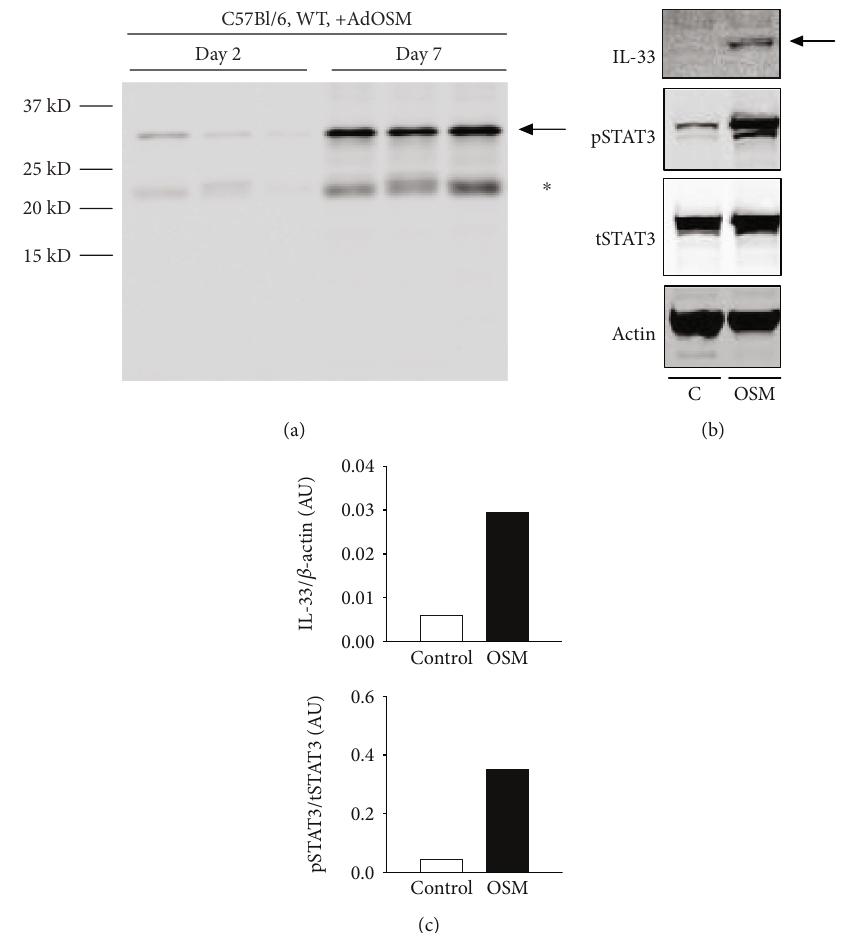
Figure 9: Comparison of AdOSM-induced IL-33 expression in C57Bl/6 mouse lung using the Nessy-1 monoclonal antibody and OSM- induced IL-33 upregulation in Human Type 2 Alveolar Epithelial Cells (A549). (a) C57Bl/6 wild-type (WT) or IL-33 knockout (IL-33KO) mice were endotracheally administered AdDl70 (control) or AdOSM for 7 days, and whole lung cell lysate was analyzed for the expression of IL-33 by Western blotting using the Nessy-1 monoclonal antibody. (b) 300,000 A549 cells/well in 6-well plates were stimulated with human OSM (20 ng/ml) for 24 hours, and Western blot analysis was performed for detection of IL-33 (Nessy-1), pSTAT3 (NEB Cell Signaling), tSTAT3 (NEB Signaling), and actin (Santa Cruz) from cell lysates. Black arrow indicates migration of IL-33-speci fi c band. ∗ Mouse IgG light chain. (c) Densitometry of IL-33 and pSTAT3/tSTAT3 signal was completed using Image Studio Lite for samples in (b). AU: arbitrary